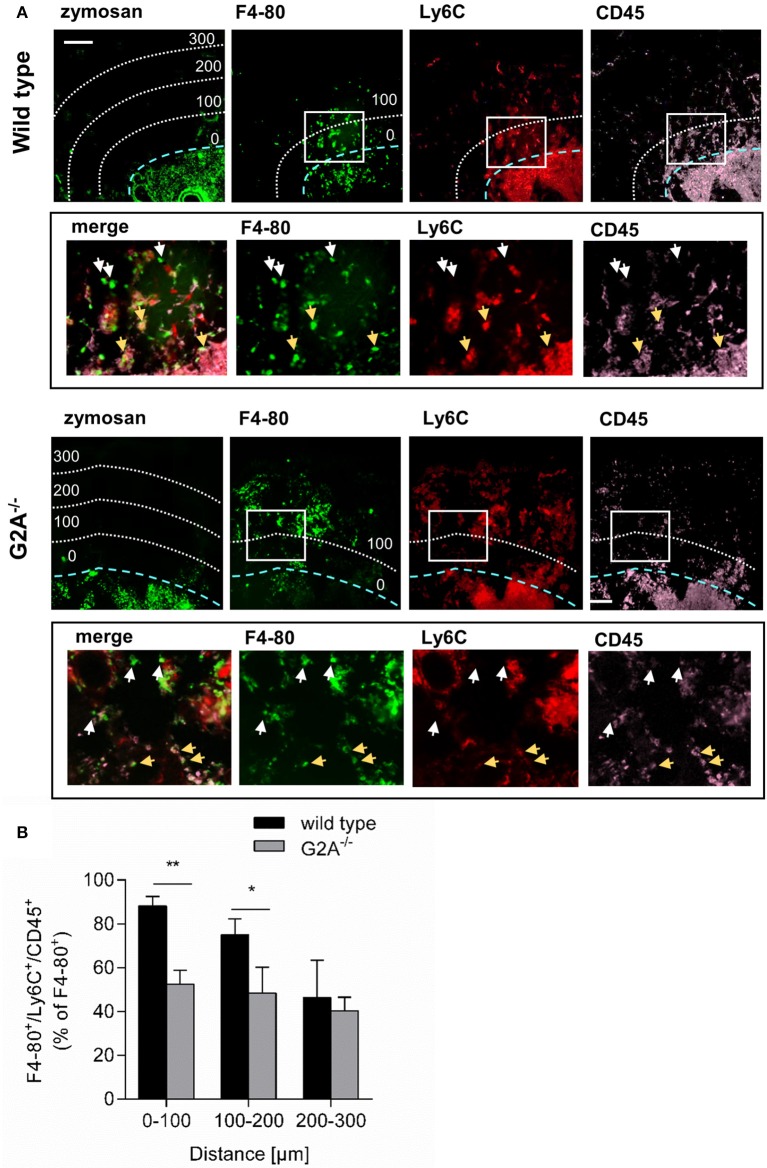
G2A-deficieny decreases the number of monocyte-derived macrophages at the center of inflammation. (A,B) Inflamed paws from wild type and G2A−/− mice were prepared 24 h after zymosan injection (10 μl, 3 mg/ml) for immunohistological analysis of CD45, Ly6C, and F4–80. Representative MELC images (A) and quantitative analysis (B) of monocyte-derived macrophage distribution are shown. The blue dotted line shows the border of the zymosan-containing area and the white dotted lines indicate 100, 200, and 300 μm distance from the border. All images are shown in false colors. White squares depict the area shown in the lower panels (black box). White arrows depict F4-80+/Ly6C+/CD45+ monocyte-derived macrophages and light brown arrows depict F4-80+/Ly6C−/CD45− resident macrophages. Data are shown as mean ± S.E.M. (n = 3–4). Unpaired one-tailed Student‘s t-test. *p < 0.05, **p < 0.01. The white bar indicates 100 μm.